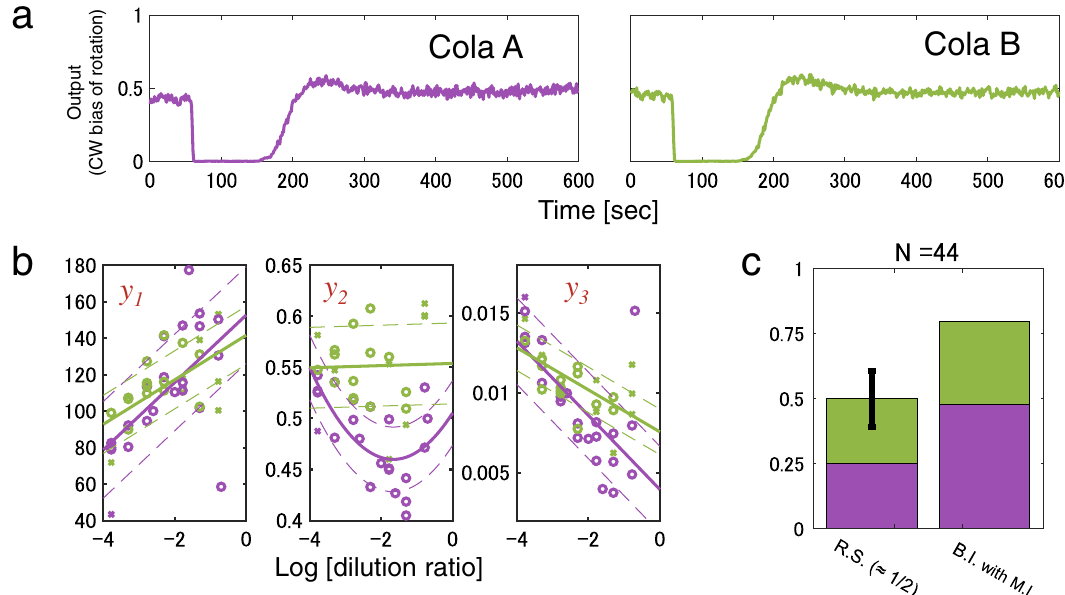
Figure 4. Discrimination of unidentified chemical mixtures with DeSIRAM. ( a ) CW bias traces caused by chemical composition stimuli of two similar, but distinct, cola beverages, cola A (left) and cola B (right). Chemotactic responses to solutions diluted to 1:2000. ( b ) Concentration dependencies of first 3 indexes, y 1 , y 2 , y 3 , of characteristic vectors. Each graph is coloured according to chemical solution species (purple, cola A; green, cola B). Plot makers and lines have the same meaning as in Fig. 2c. ( c ) Accuracy rate of decipherment for chemical compositions (cola A, n = 22; cola B, n = 22). The left bar shows theoretical decipherment accuracy of RS. The black line on the left bar indicates the standard deviation calculated numerically. The right bar shows the accuracy rate by DeSIRAM. Decipherment accuracy of 0.80 is high relative to that of RS. The probability of an identification success rate of 0.80 by RS is 4.0 × 10 −5 . DeSIRAM with E. coli distinguished two solutions, although the compositions are not